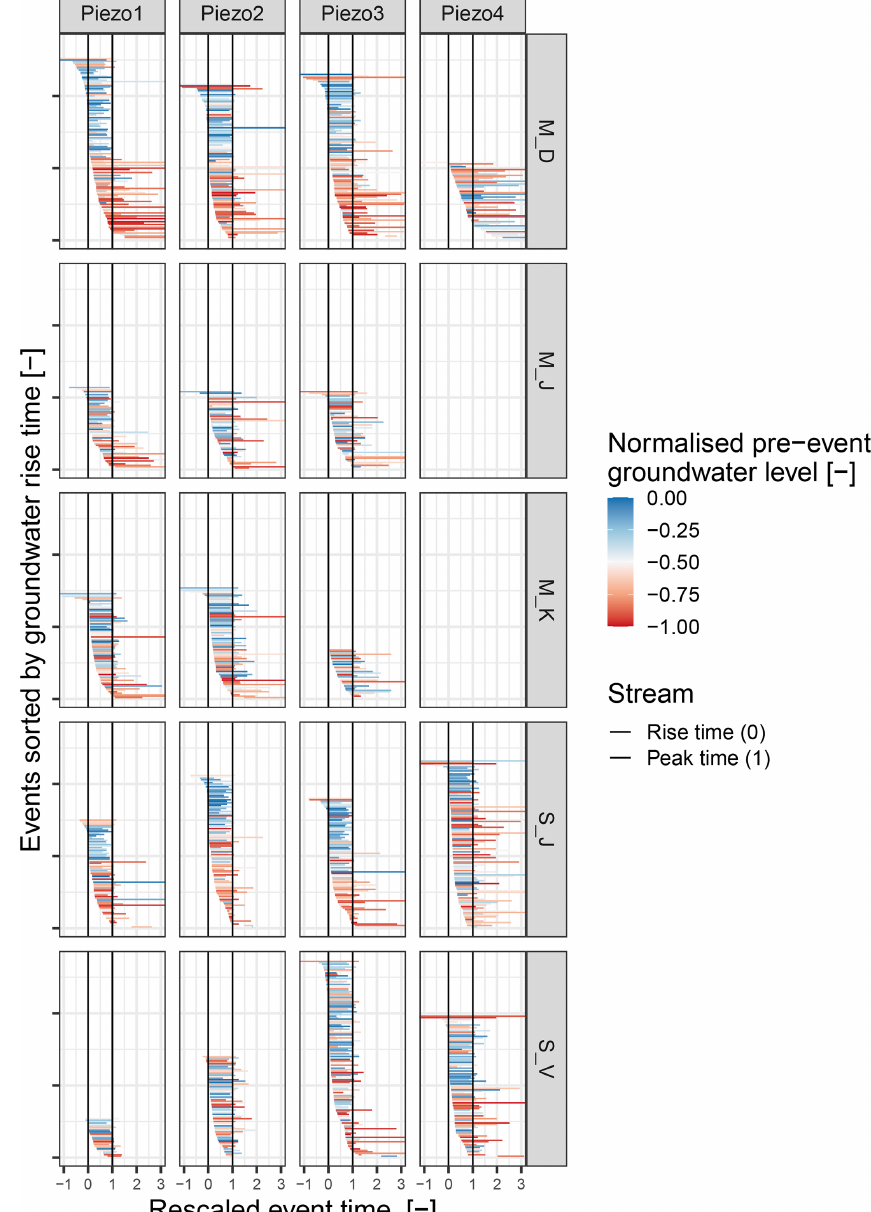
Figure 9. Timing of groundwater response relative to stream response. The two vertical lines at 0 and 1 represent the normalised rise and peak time of each individual streamflow event. Horizontal bars each represent a groundwater event with its individual normalised rise and peak time. Bluish colours indicate high and reddish colours indicate low pre-event groundwater